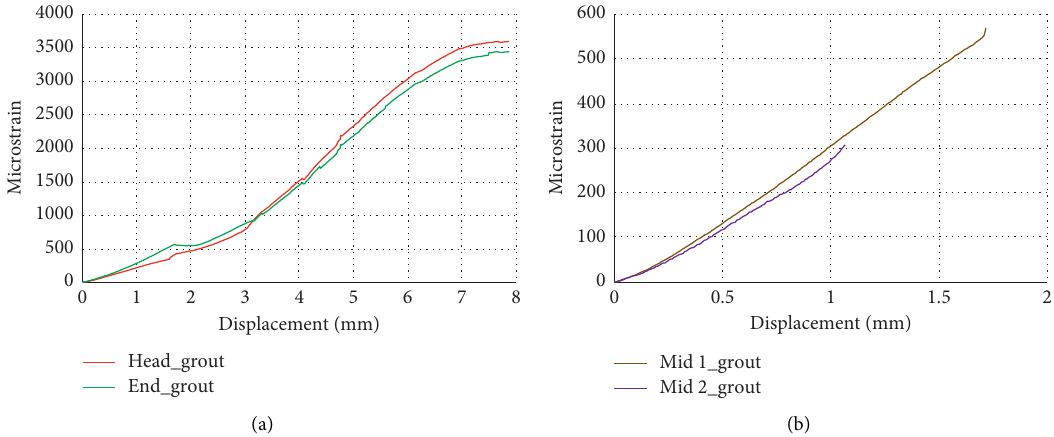
Figure 20: Strain vs. displacement for uncoated GFRP rock bolt sensor fixed with grout at (a) head and endpoints and (b) midpoints.